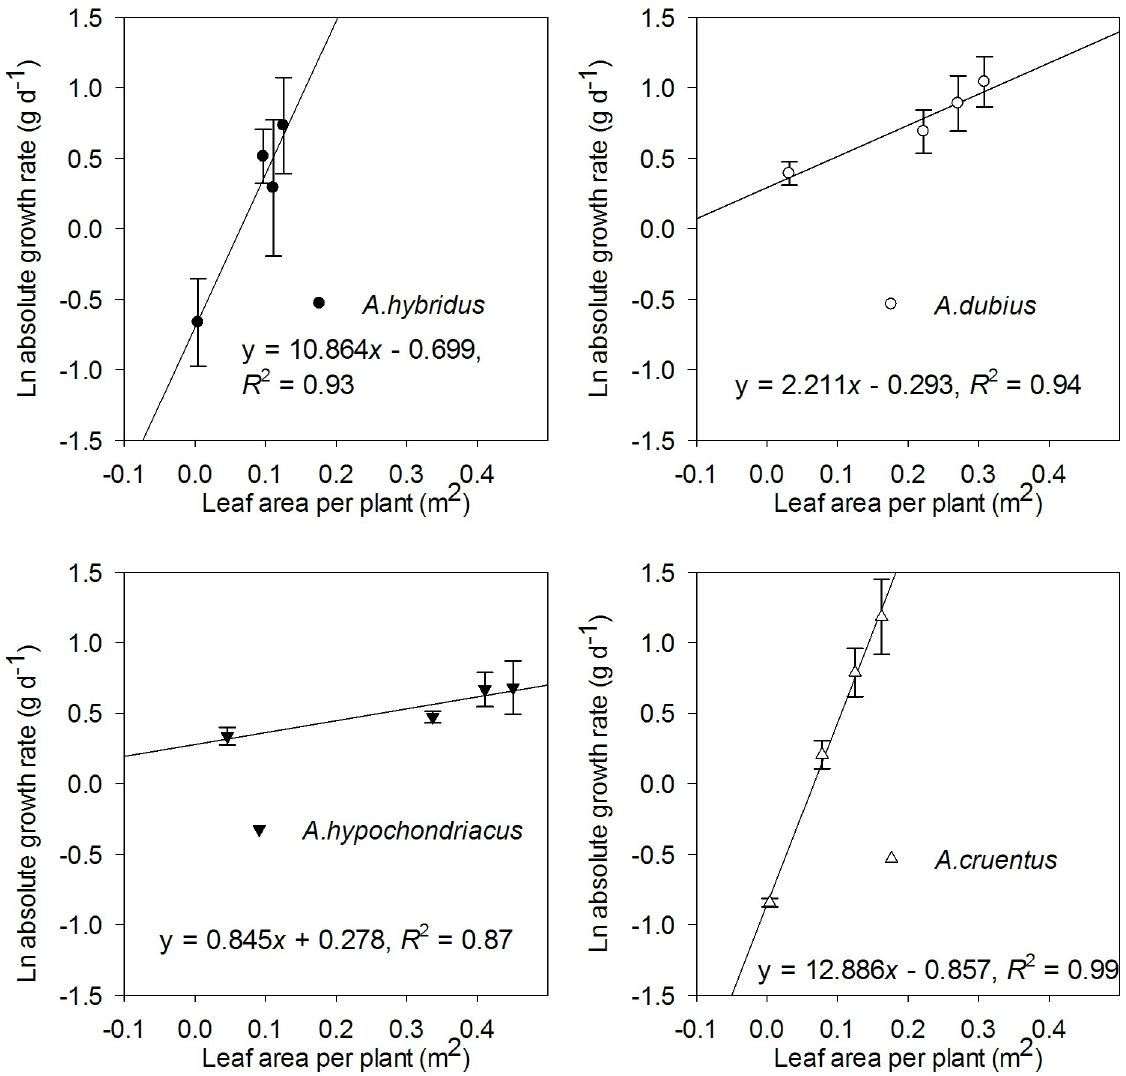
Fig 5. The relationship between the natural logarithm of absolute growth rate (AGR) and leaf area per plant of four amaranth species ( A . hybridus , A . dubius , A . hypochondriacus , and A . cruentus ). The four data points for each species represent the means of the variables at the four measurement date intervals. Bars represent the ± SD of the